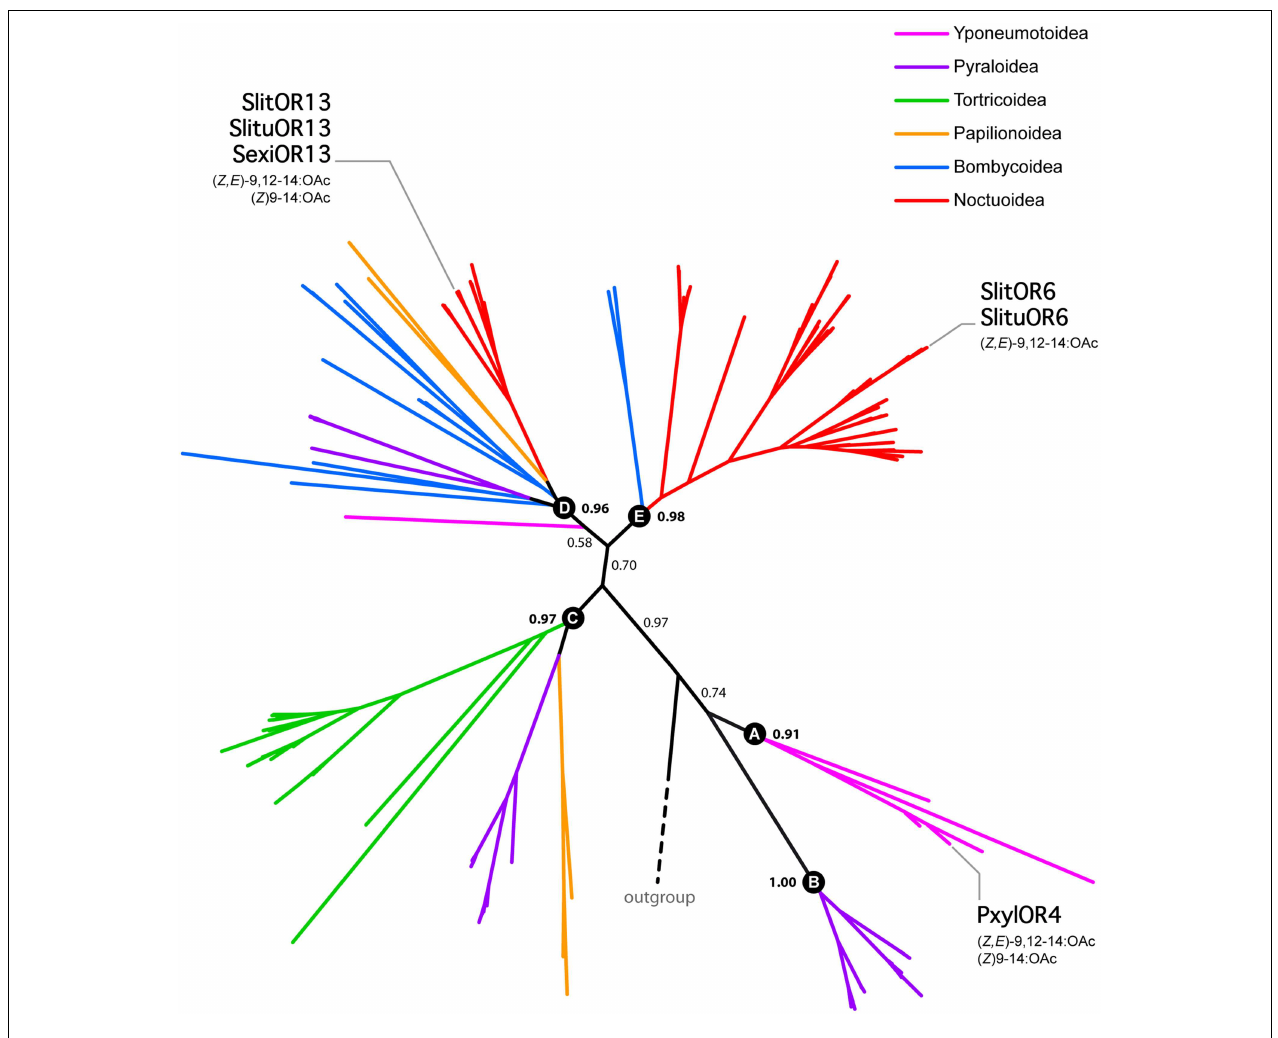
Lepidoptera super-families. Letters from A to E correspond to different paralogous lineages. Support values correspond to the result of the likelihood-ratio